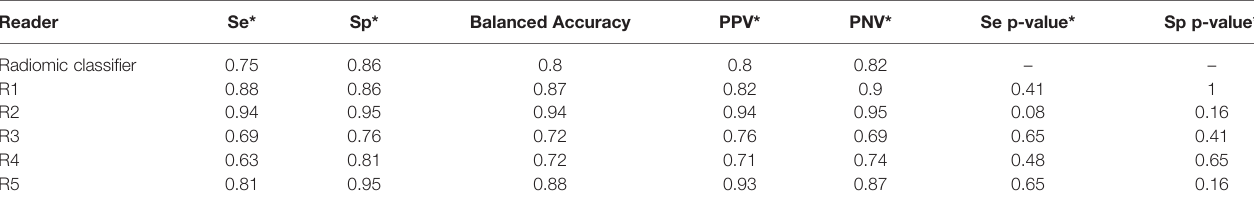
TABLE 2 | Sensitivities, speci fi cities, balanced accuracies, positive predictive values, negative predictive values of the radiomic classi fi er and of the neuroradiologists (R1, R2, R3, R4, R5) on the test set.